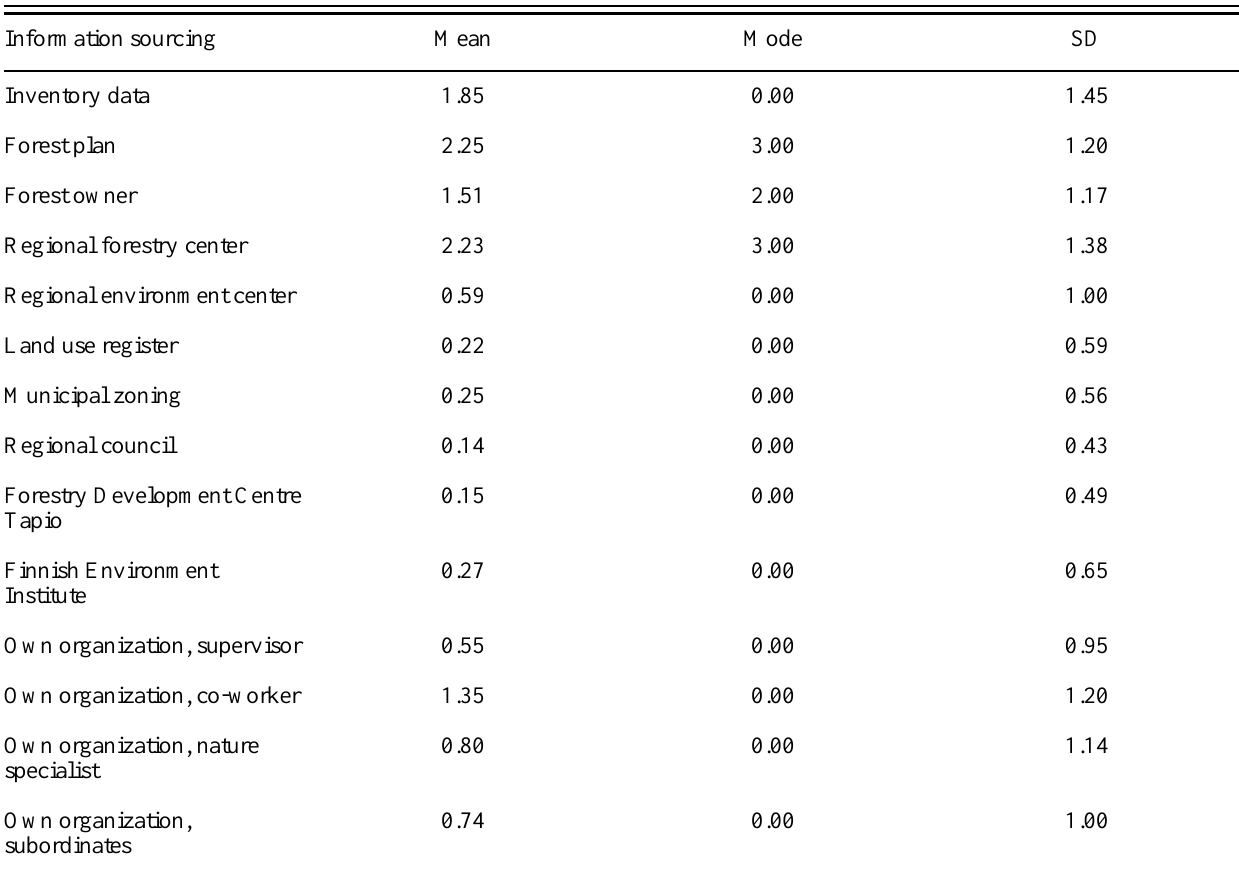
Table A3-3. Descriptive statistics of information